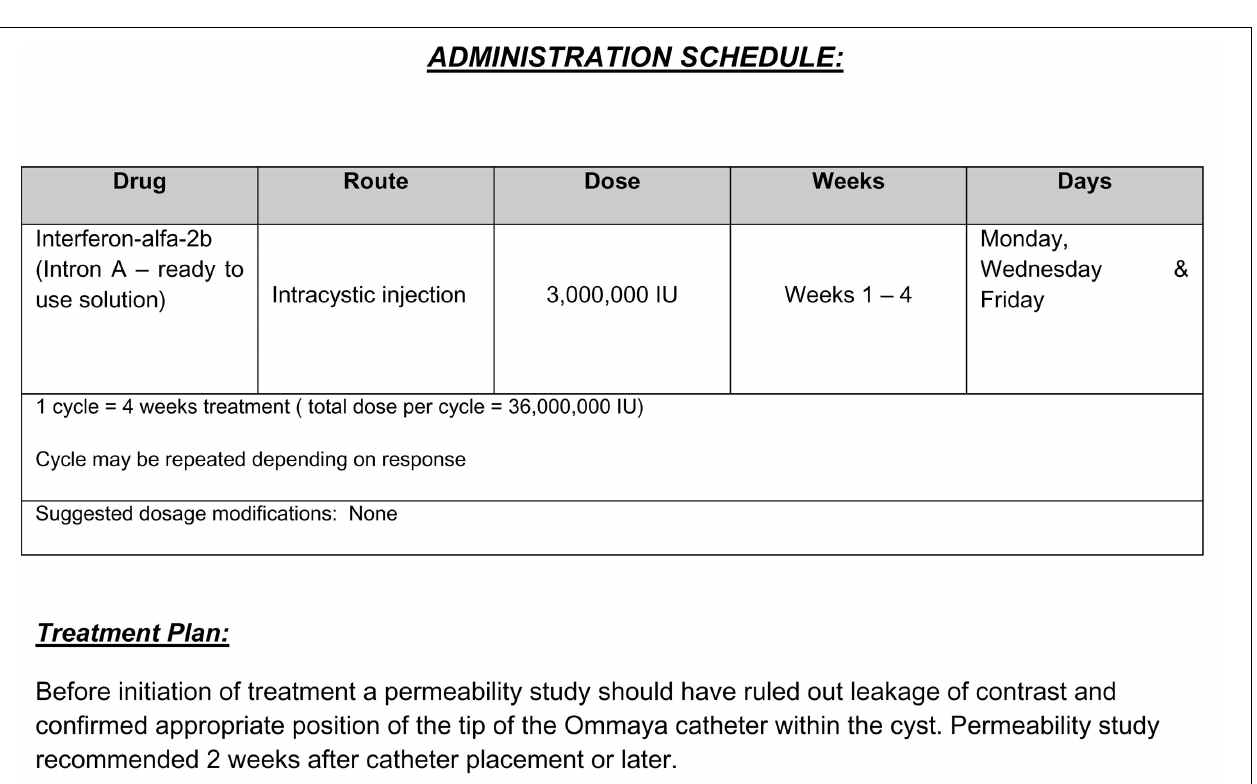
FIGURE 1 | SickKids standard of care protocol for intracystic interferon